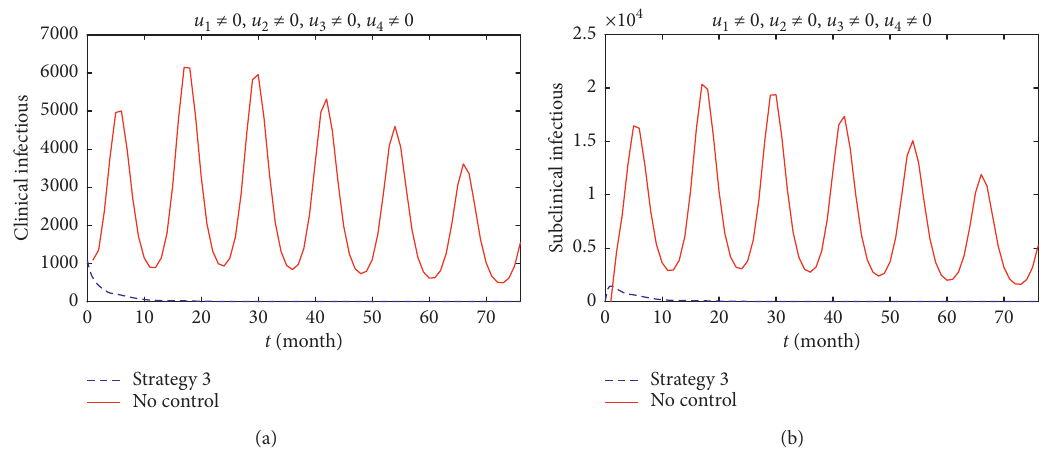
Figure 8: The time-series plots of I (a) and L (b) without (red line) and with (blue line) control Strategy 3.